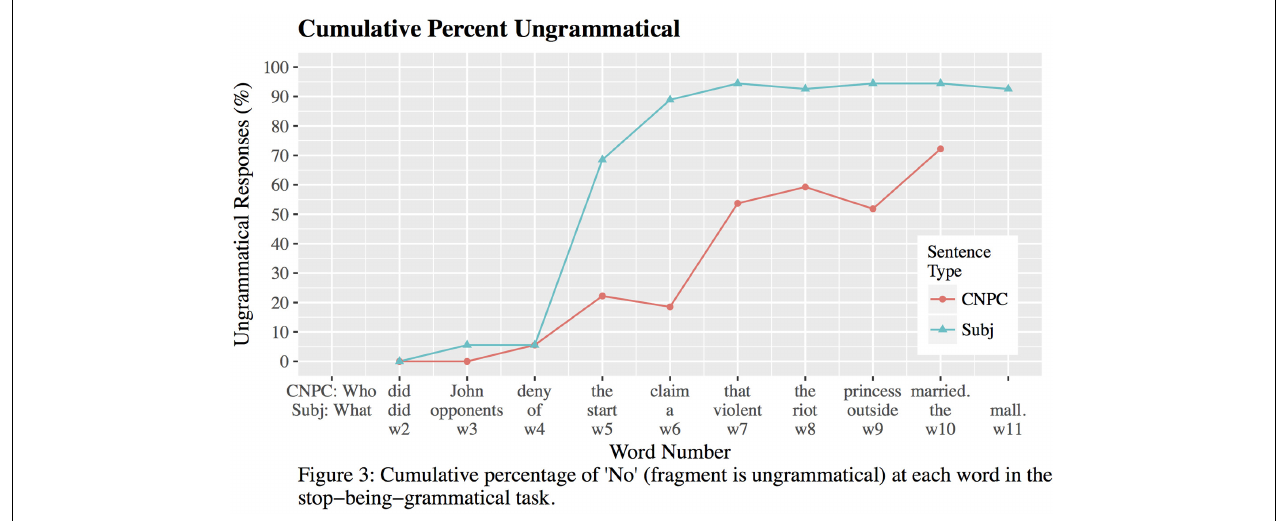
FIGURE 3 | Cumulative percentage of ‘No’ (fragment is ungrammatical) at each word in the stop-being-grammatical